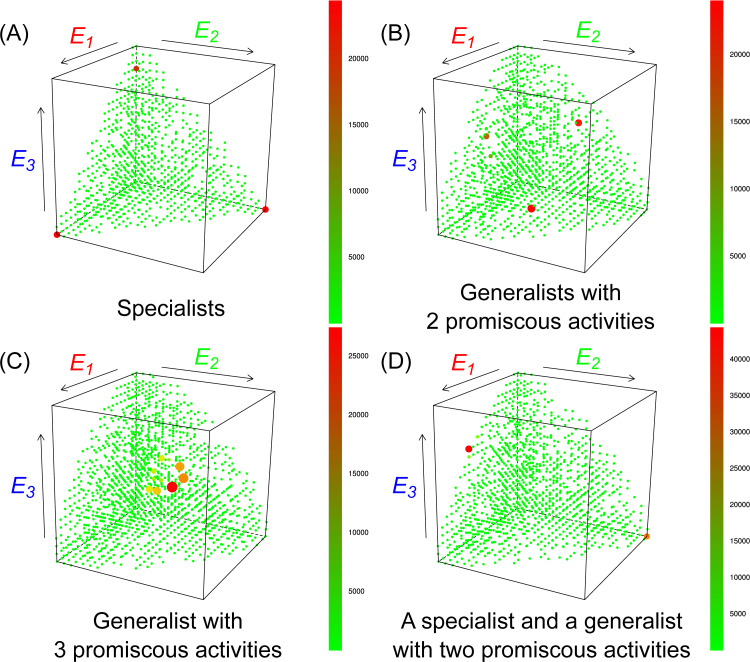
Promiscuity patterns of coexistence.The distribution of replicators under the trade-off surface of enzymatic activities after 50 000 generations at A = 3 and g = 1. Axes are scales of the three different enzymatic activities. Size and colour of dots represent the frequency of replicator groups with a certain enzymatic activity pattern. (A) a system dominated by specialists (b = 1.1, D = 5, kmax = 2.0, Nmet = 5), (B) a system dominated by two-activity generalists (b = 1.5, D = 5, kmax = 2.5, Nmet = 5), (C) a system dominated by three-activity generalists (b = 1.6, D = 0, kmax = 2.0, Nmet = 5). On (D) a two-activity generalist type and its complementary specialist dominate the system (b = 1.4, D = 5, kmax = 2.0, Nmet = 5).